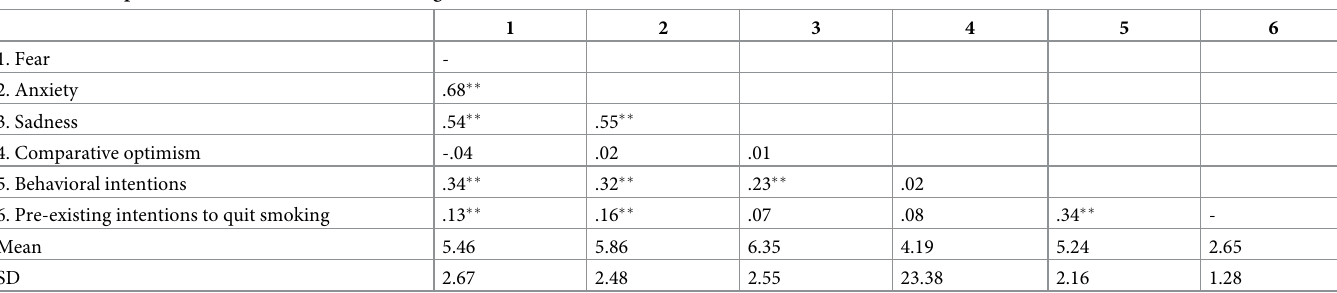
Table 2. Descriptive statistics and correlations among variables.